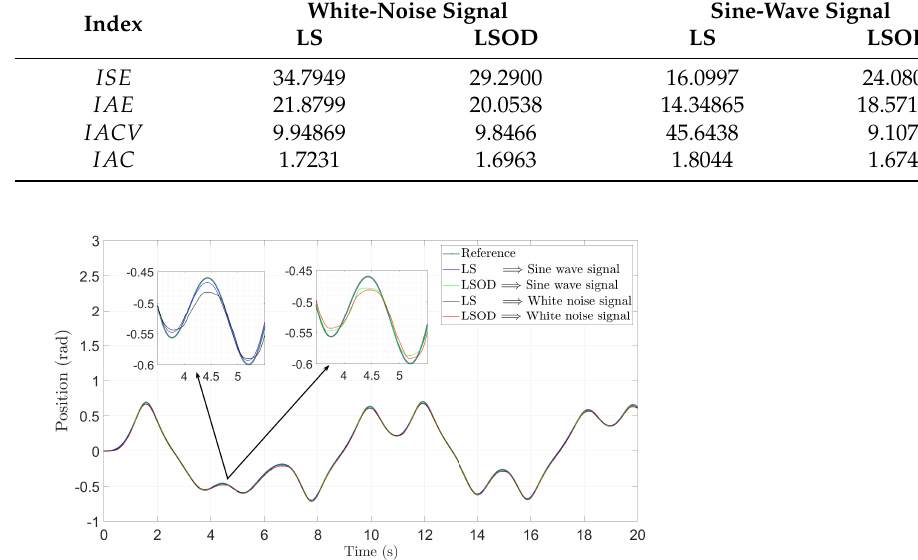
Table 6. Performance indexes produced by control law (61) with parameter estimates β ∗